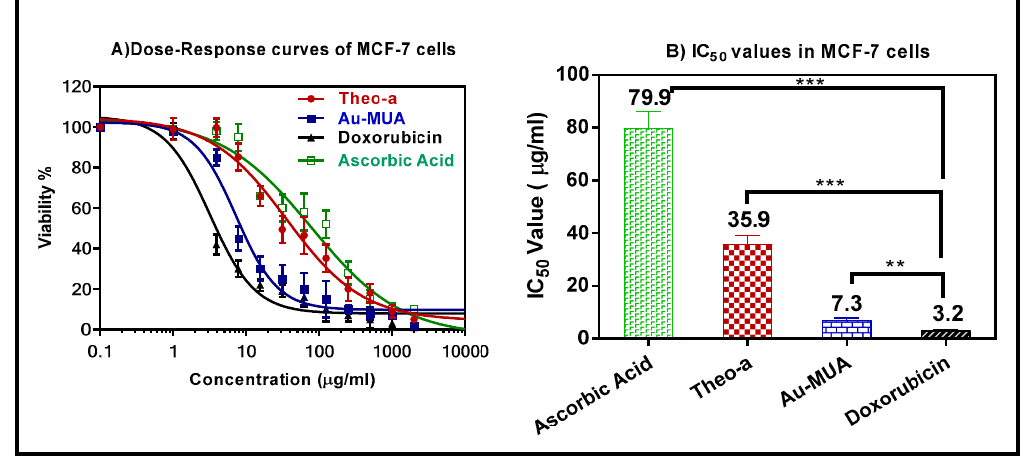
Figure 5. Dose-response curve ( A ) and half maximal inhibitory concentration (IC 50 ) values ( B ) of pheophytin a (pheo-a) in Michigan Cancer Foundation 7 (MCF-7) cells in comparison to doxorubicin, ascorbic acid, and gold coated mercaptoundecanoic acid (AU-MUA). All the values are expressed as mean ± standard deviation; n = 3, *** p < 0.001, and ** p < 0.01.